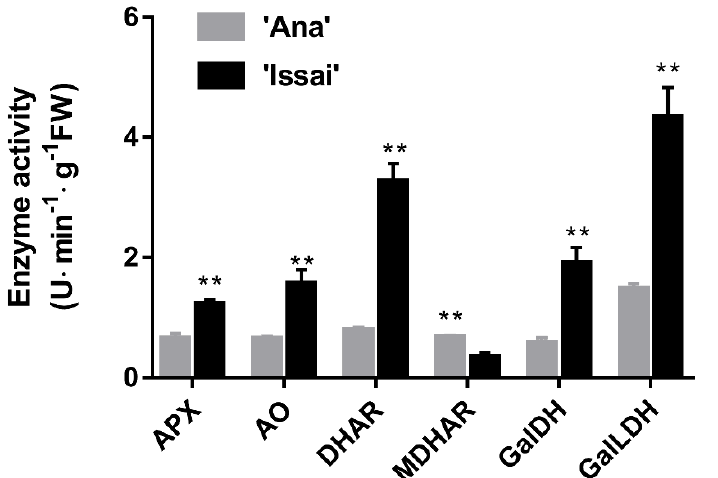
Figure 5. Enzymatic activity of ascorbic acid biosynthesis pathway at 84 DAF. Data are presented as mean ± standard error from three biological replicate assays (** p < 0.01). The error bars represent standard error of the means.